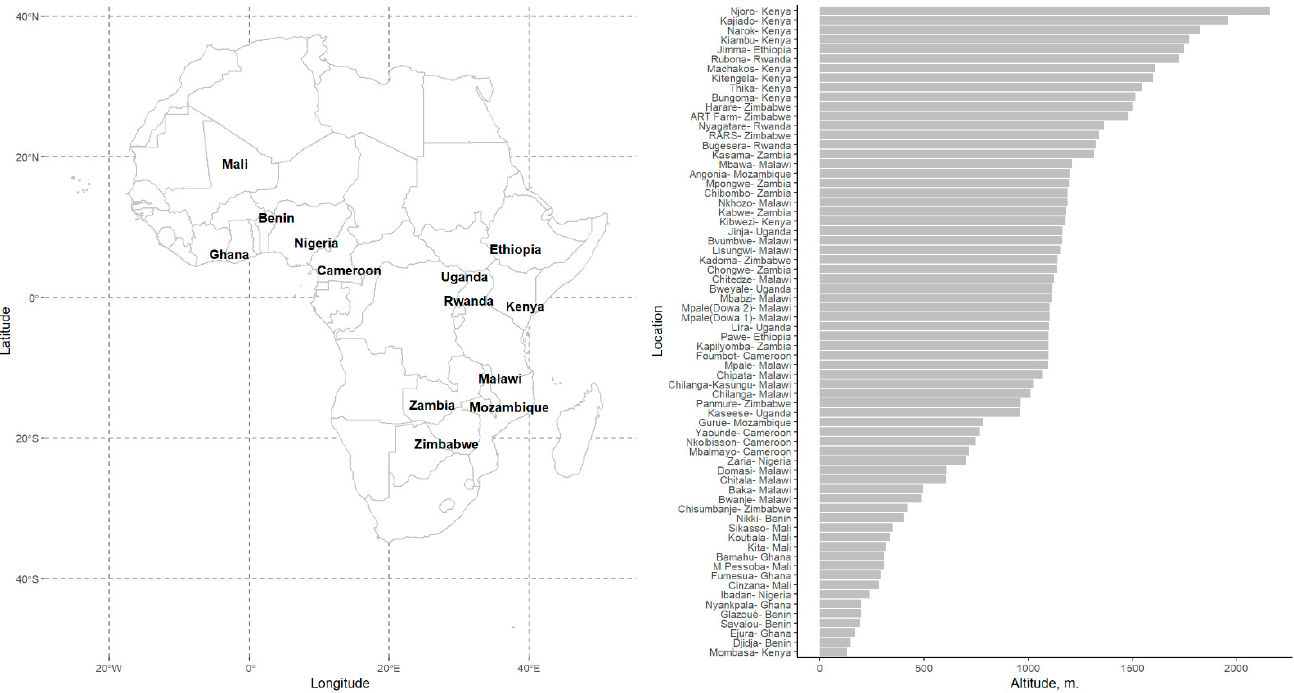
Figure 2. Countries, trial sites, and altitudes, considered for a soybean maturity prediction model adapted to soybeans grown in African conditions (Soybean Innovation Lab, Pan-African Variety Trials: SIL–PAT, 2015–2020).